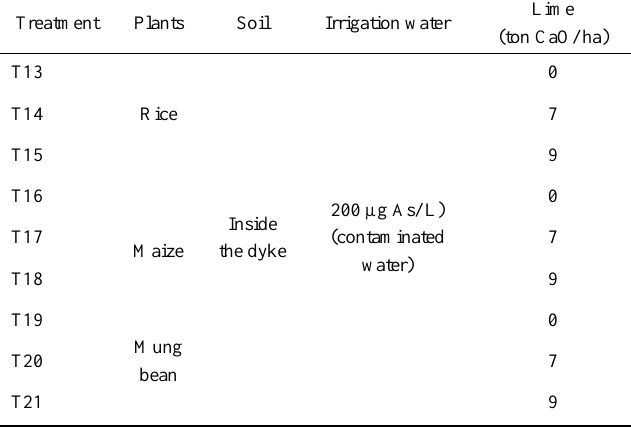
Table 4. Treatments of various lime rates of rice, maize and mung bean